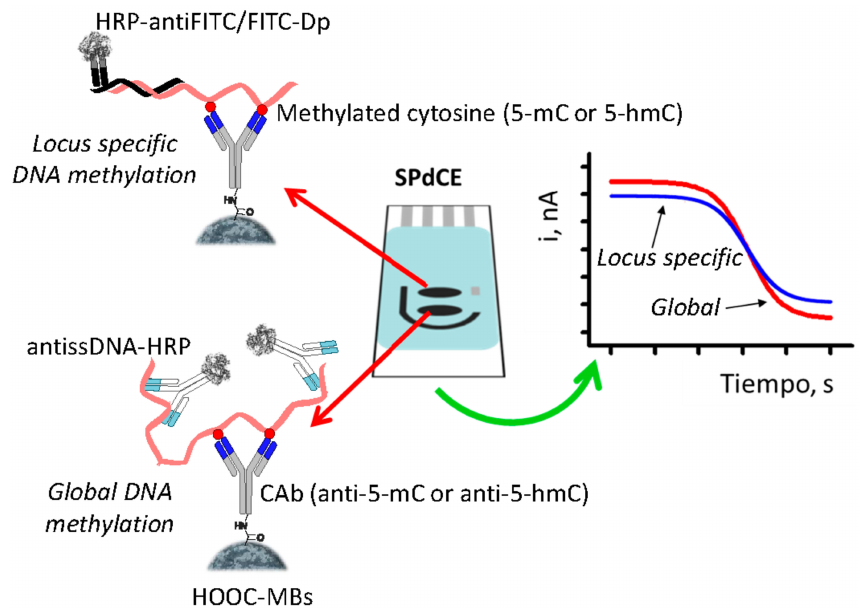
Figure 7. Schematic display of the dual electrochemical bioplatforms developed for the detection of 5-mC or 5-hmC both at global and gene-specific levels. Figure drawing based on